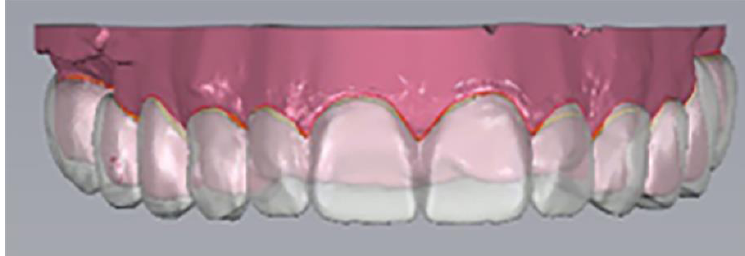
Figure 3. Case 1—Digital project of the DEFS, limited to the maxillary arch.